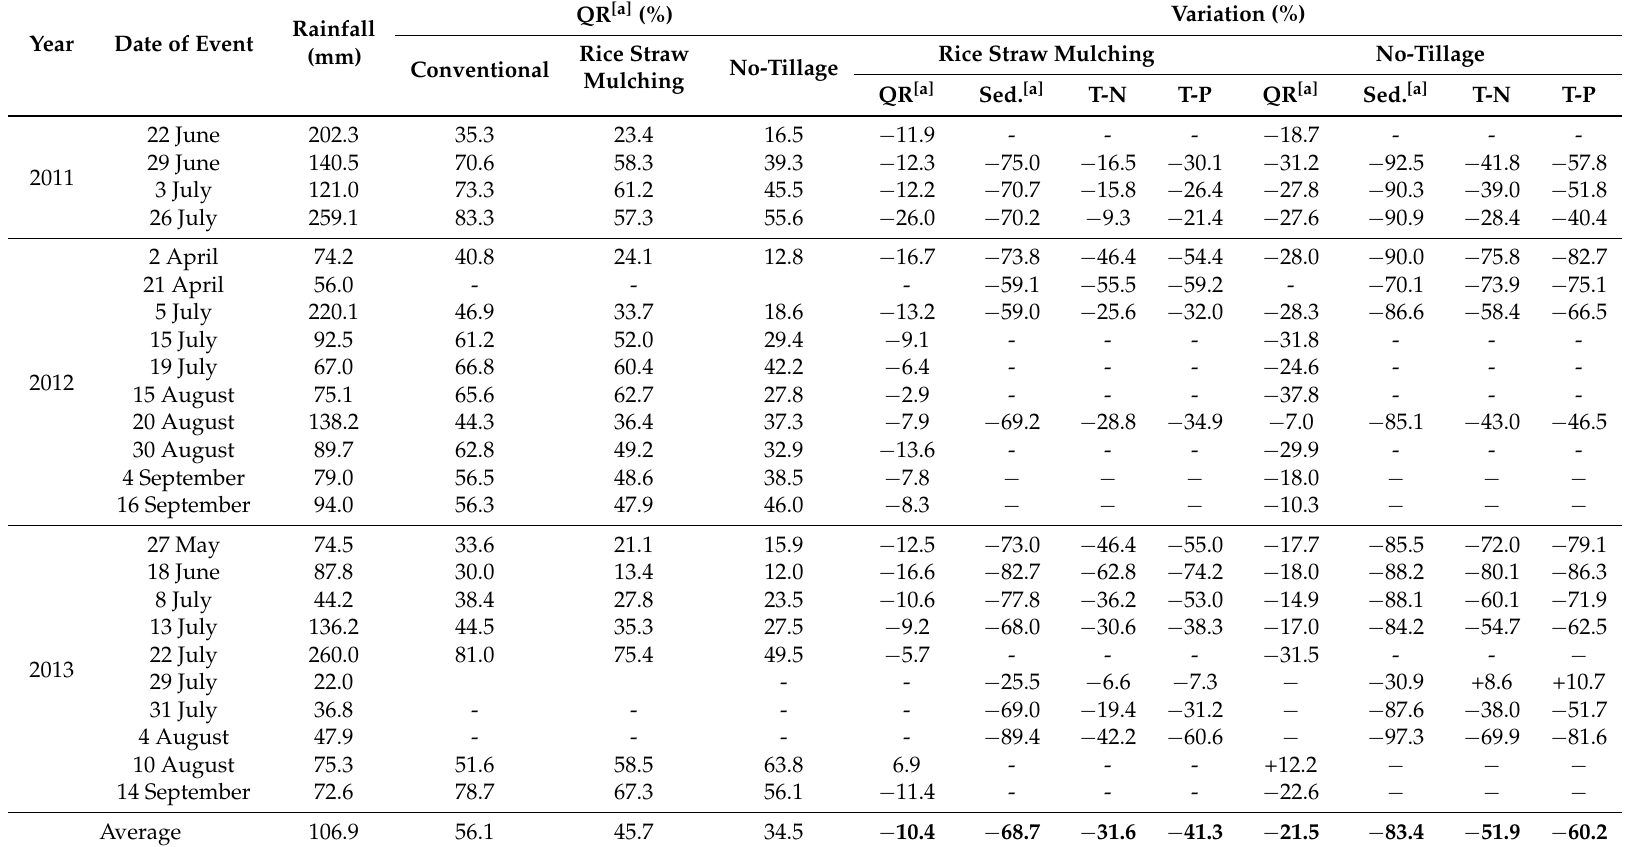
Table 5. Variation of runoff and NPS pollution for each rainfall event for the rice straw mulching and no-tillage